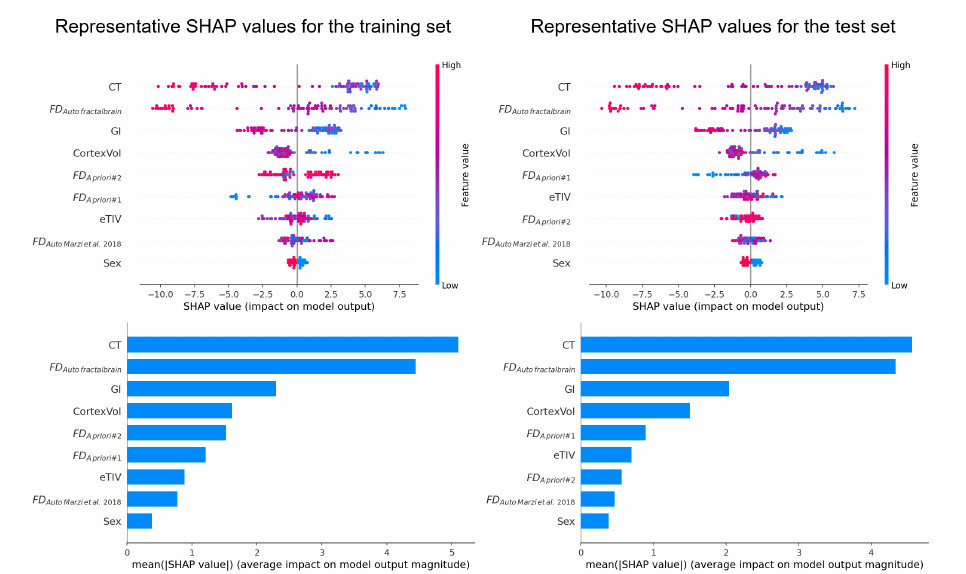
Figure 4. Results for the ICBM regression task in a five-fold nCV over 100 repetitions. Top row: beeswarm summary plots of representative SHAP values for the training (on the left ) and test sets (on the right ). The given SHAP explanation is represented by a single dot on each feature row for each sample (i.e., subject). The SHAP value of each feature determines the x position of the dot, and dots pile up along each feature row to show density. Color is used to display the original value of the feature. Bottom row: summary bar plot representing global feature importance as represented by the mean absolute SHAP value for that feature over all the given samples for the training (on the left ) and test sets (on the right ).